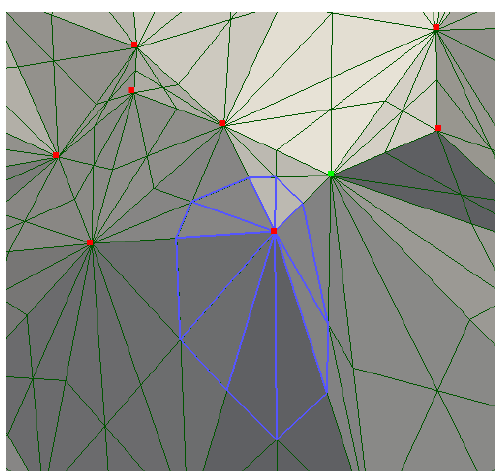
Figure 3. The triangles incident towards the first vertex r i on the dual grid comprise an initial approximated Voronoi cell (rendered as a blue wireframe); the centre vertex is rendered in